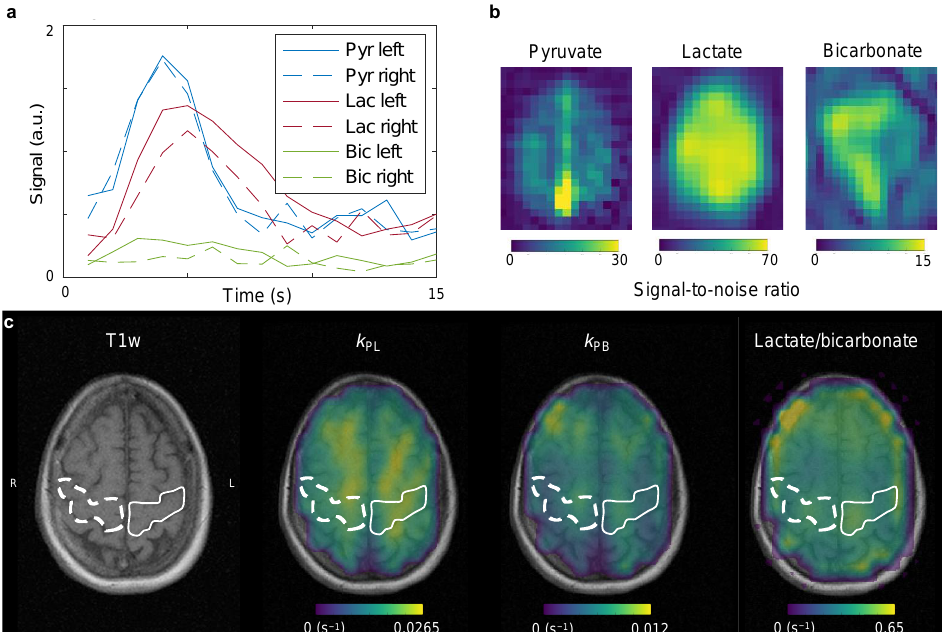
Figure 3. After administration of hyperpolarized [1- 13 C]pyruvate, dynamic images were acquired, yielding time curves in the motor cortex as presented in ( a ). The signal-to-noise ratio summed over time is presented in ( b ). Kinetic fitting ( c ) of the dynamic data allows estimation of conversion of pyruvate to lactate ( k PL ) and bicarbonate ( k PB ). Further, the model-free ratio of the lactate to bicarbonate signals is shown. Increased conversion to lactate was observed in the left hand motor area compared to the right (solid versus dashed lines).